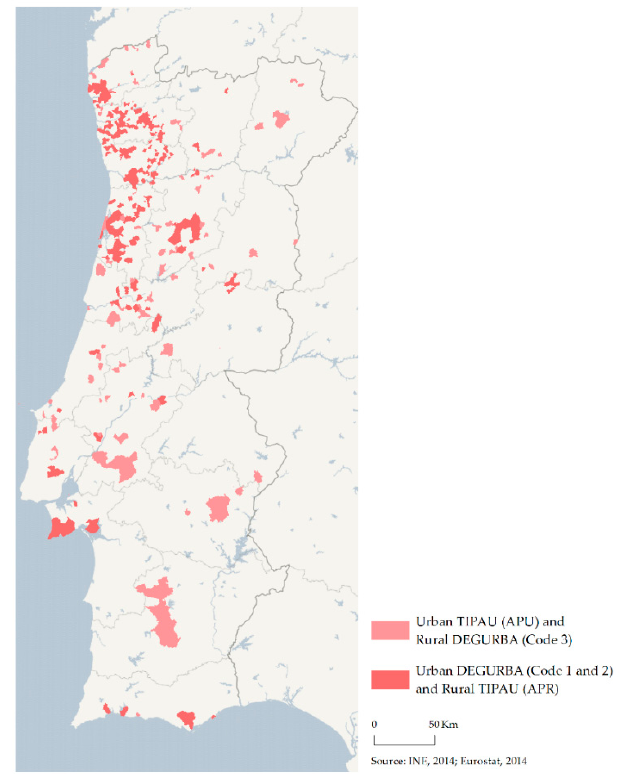
Figure 8. Parishes with different urban classification comparing TIPAU 2014 and DEGURBA 2014.